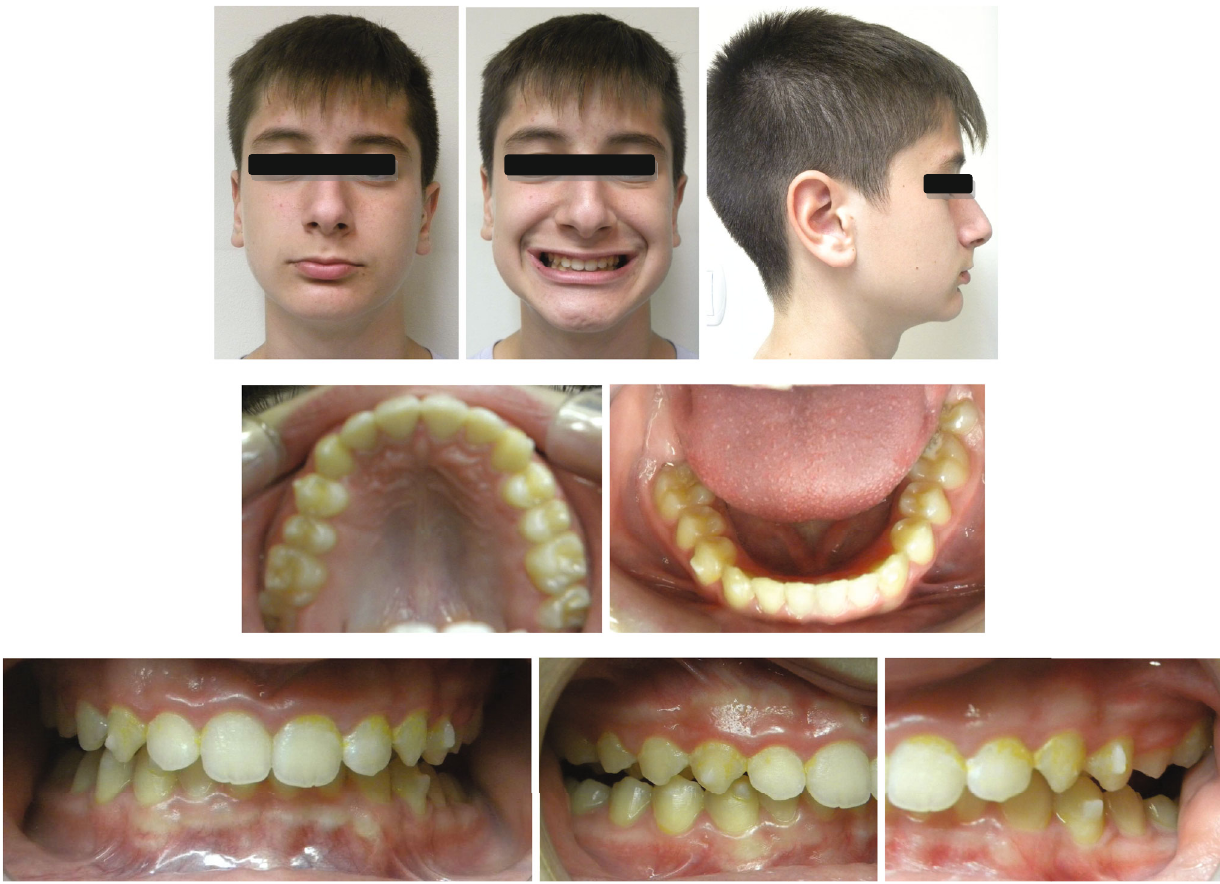
Figure 4: Photographs after the MA